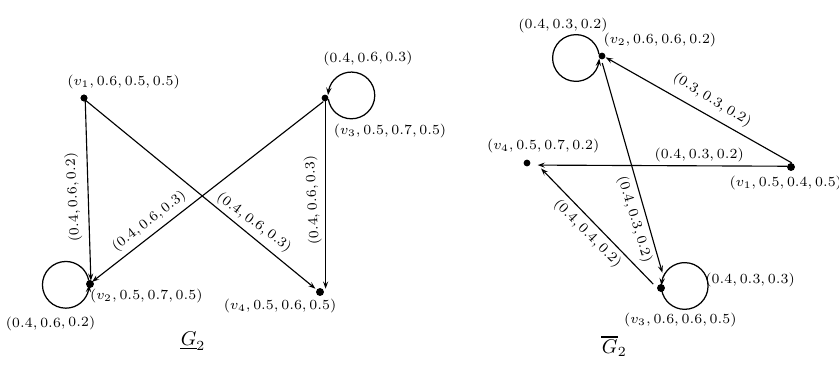
Figure 3. Neutrosophic soft rough graph G 2 “ p G 2 , G 2 q Figure 3: Neutrosophic soft rough graph G 2 = ( G Figure 3: Neutrosophic soft rough graph G 2 = ( G